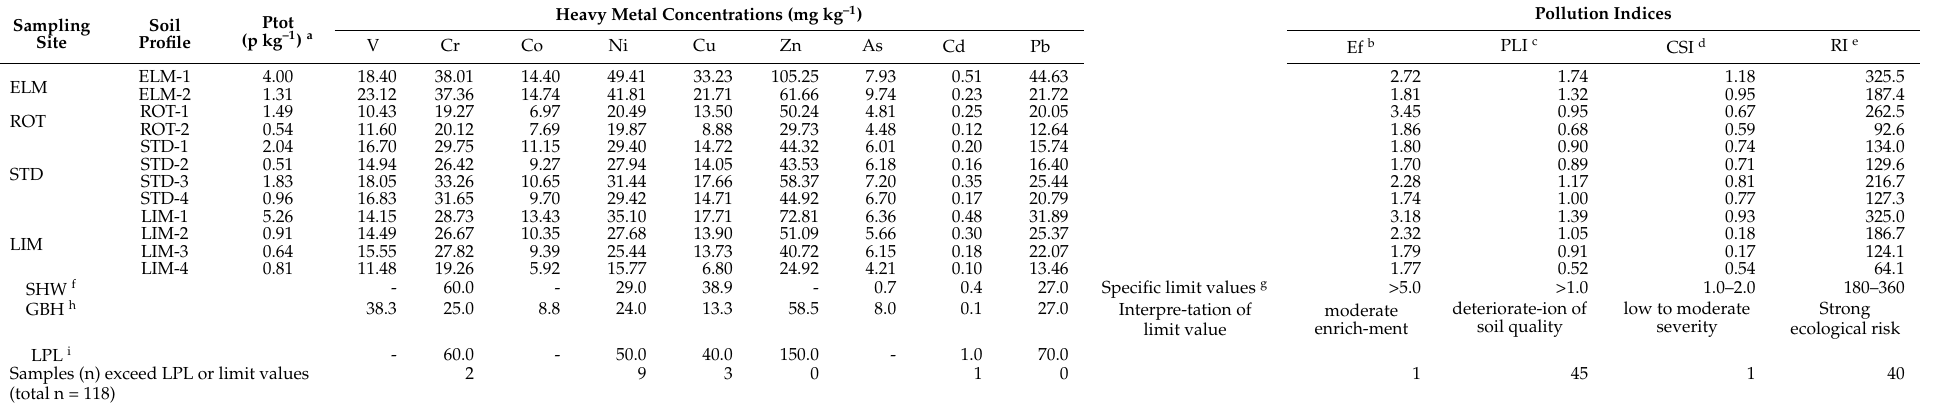
Table A1. Overview of average plastic and heavy metal loads with calculated pollution